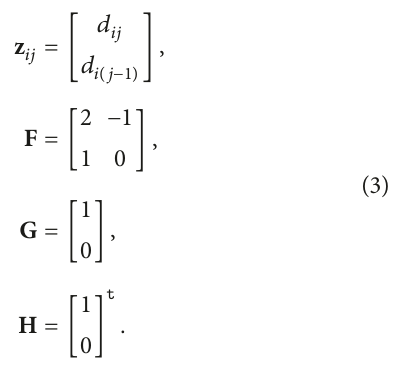
Figure 4: Step 1 . An example of a set of missing diameters ( 𝑦 𝑖1 ,..., 𝑦 ,𝑦 , . . . ) and observed diameters ( 𝑦 𝑖5 𝑖7 are estimated by using Bayesian estimation model.